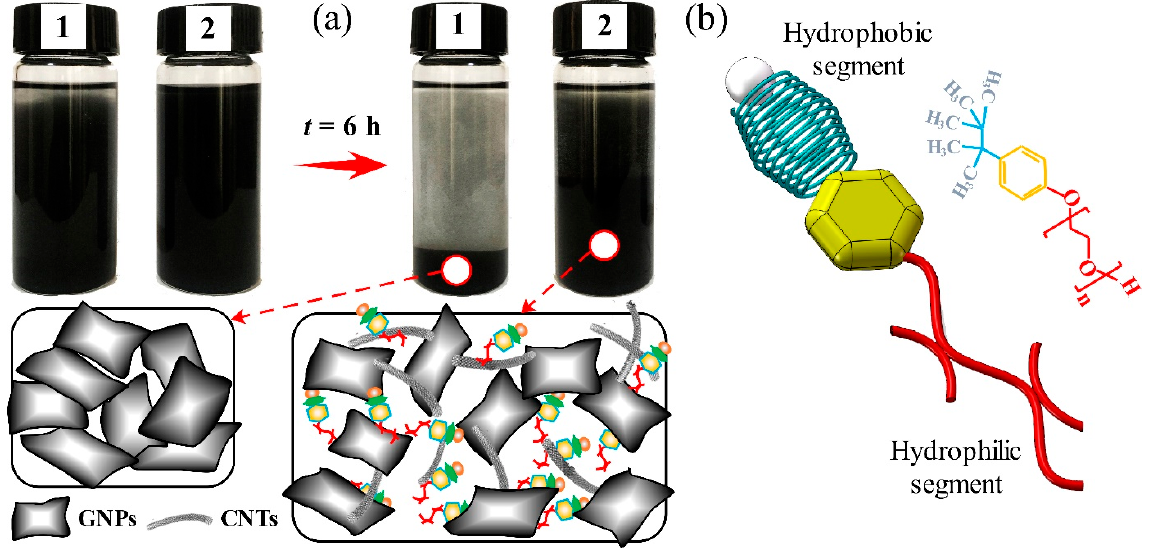
Figure 1. Physical modification: ( a ) suspension stability tests for 1: GNPs and 2: CNT@X+GNPs nanoparticles in acetone solvent, and ( b ) schematic diagram showing a single Triton™ X-100 molecule and its chemical structure.